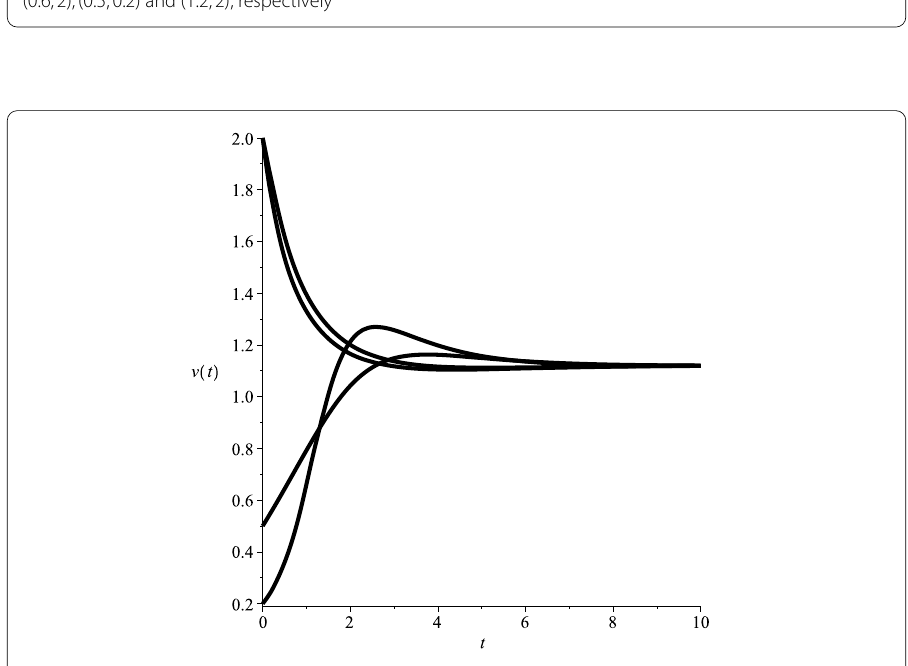
Figure 3 Dynamic behaviors of the predator species in system (5.3), the initial condition ( u (0), v (0)) = (0.1,0.5), (0.6,2),(0.5,0.2) and (1.2,2),